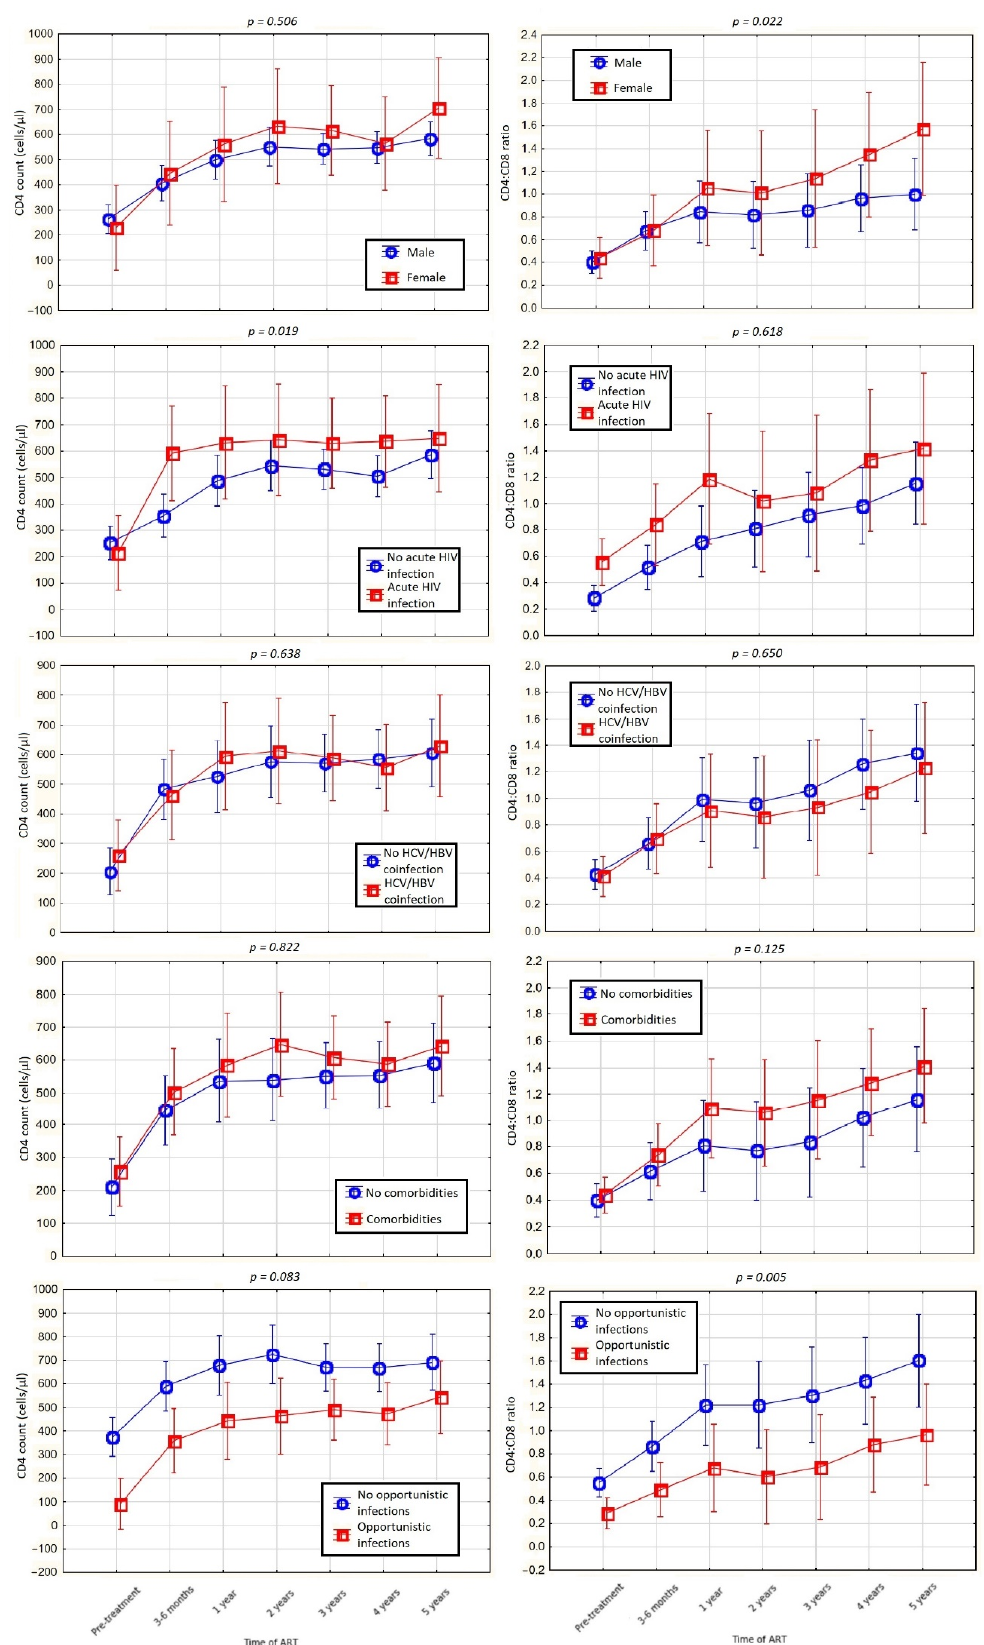
Figure 4. The results of a generalized linear model with repeated measures for CD4 cell count and CD4:CD8